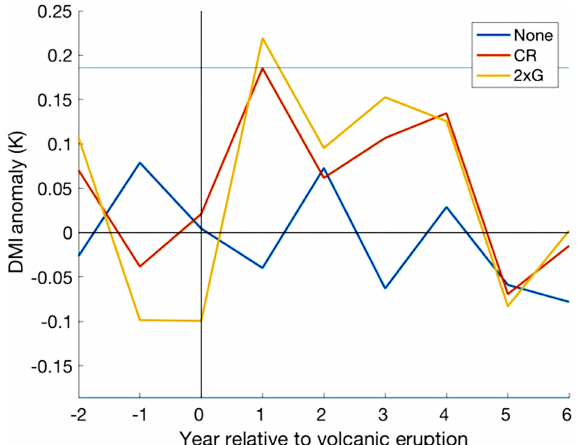
Figure 4. Multi-ensemble and multi-volcano mean DMI (dipole mode index) response to CR and “None” forcing groups and multi- volcano mean DMI response to the 2 × G forcing group over July– November (JASON). Significance was tested using the 0.6 standard deviation threshold (horizontal blue lines), and by comparing the CR and 2 × G ensembles to those without volcanic